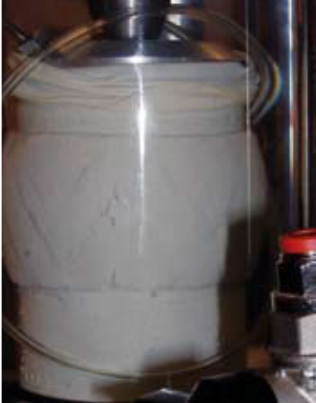
Fig. 11. Triaxial test dense sand sample of H/D = 1